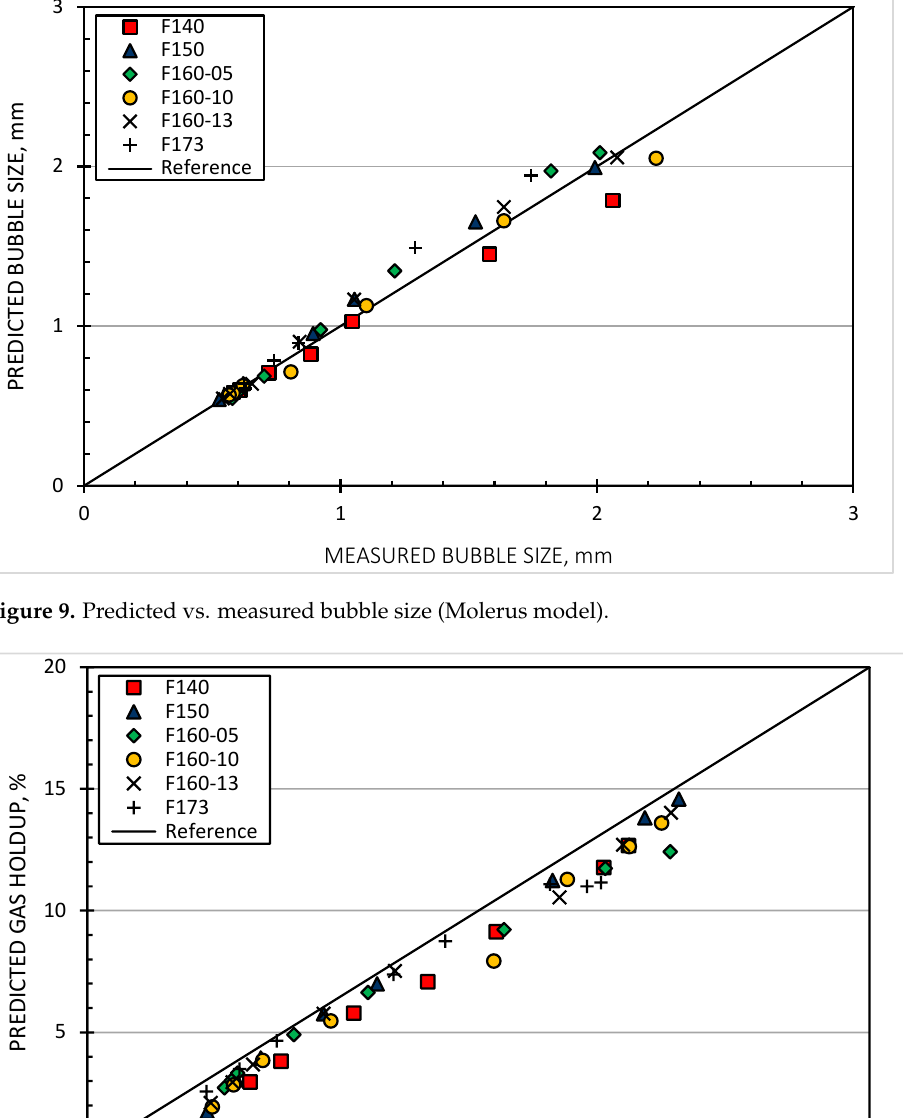
Figure 8. Predicted vs. measured bubble size (drift-flux model).